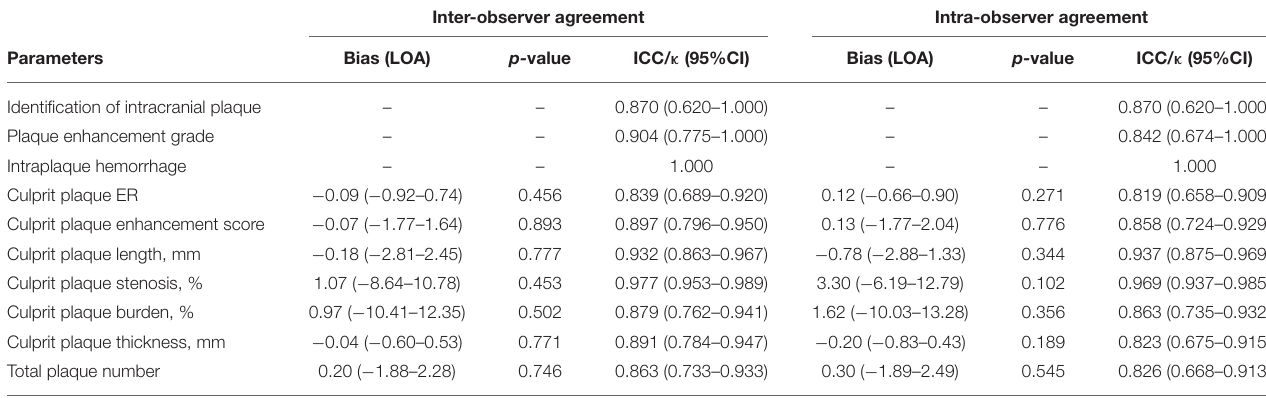
TABLE 4 | Inter-observer and intra-observer reproducibility ( N =